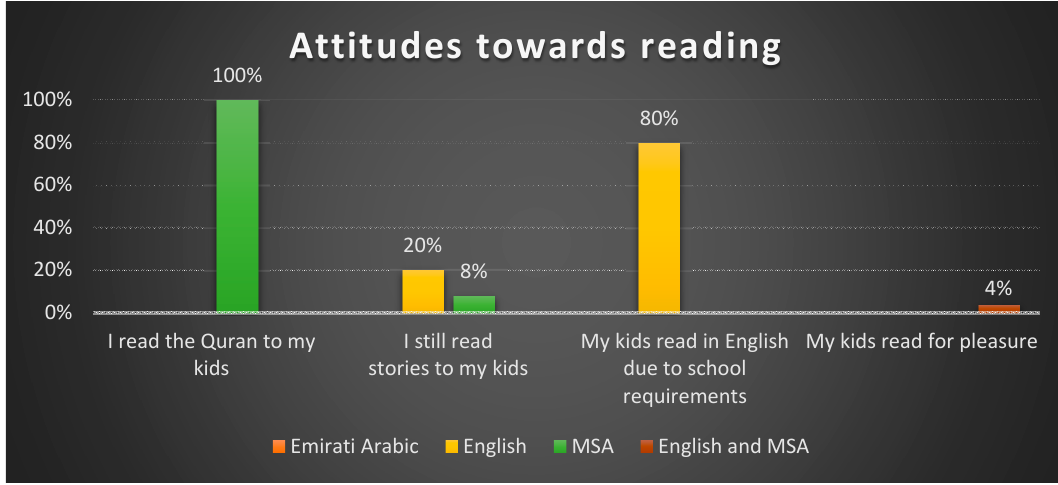
Figure 2. Emiratis Attitudes towards Reading.